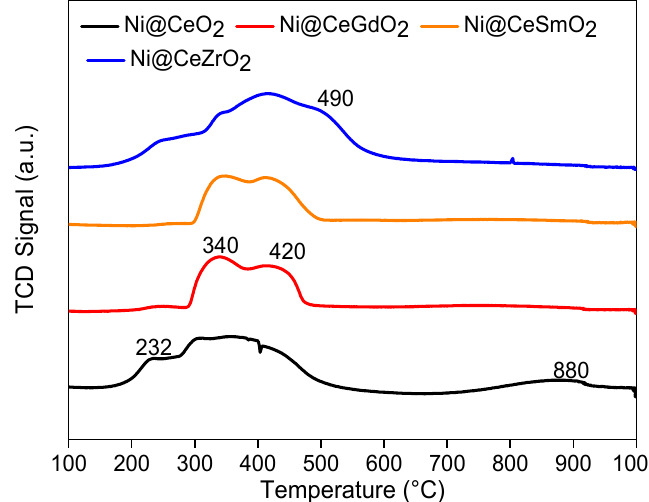
Figure 5. TPR profiles for the catalysts.